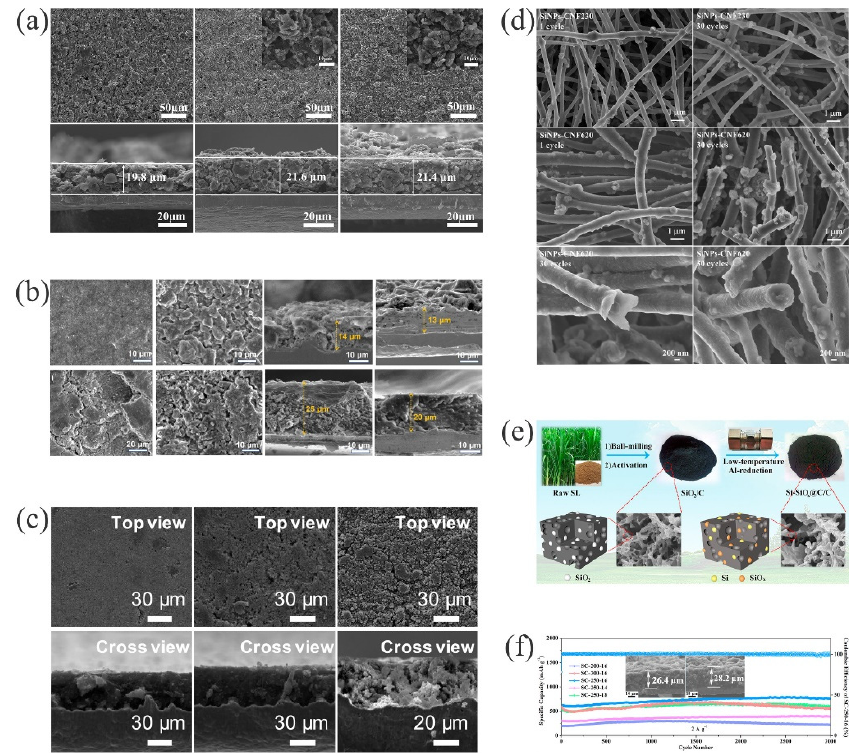
Figure 8. SEM images of ( a ) Si/C electrodes surface before cycle, after 5 and 50 cycles [220]. Reprinted with permission from Ref. [220]. Copyright 2021, J. Alloys Compd. ( b ) pure Si electrode and Si/C electrode before and after 100 cycles [221]. Reprinted with permission from Ref. [221]. Copyright